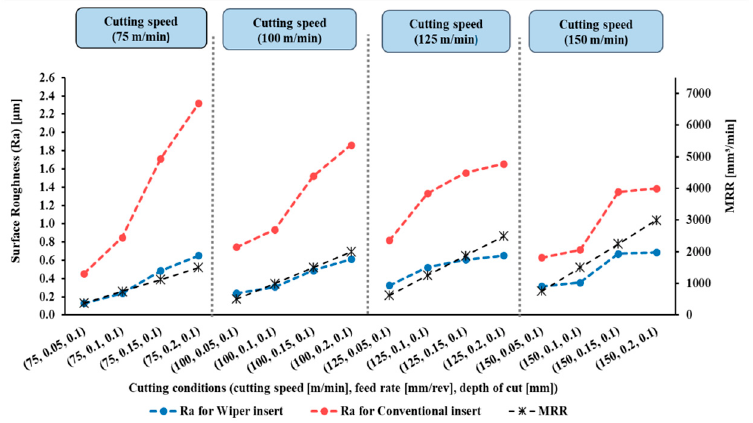
Figure 3. Optical micrograph for AISI 4340 high-strength steel: ( a ) overview microstructure and ( b ) alternate lamellas of ferrite and iron carbide within a pearlite grain.